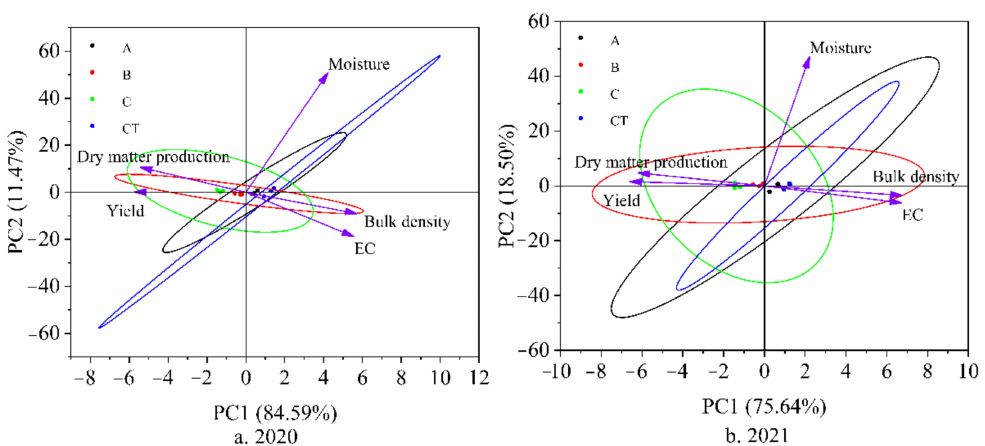
Figure 8. Principal component analysis (PCA) to elucidate the treatment–variable relationships between soil parameters and cotton yield under different smashing ridge tillage depth conditions in ( a ) 2020 and ( b ) 2021. The lines originating from the central point of the biplots show negative or positive correlations of different variables, and their closeness indicates strength of correlation with a particular treatment. CT, conventional tillage; A, 20 cm; B, 40 cm; C, 60